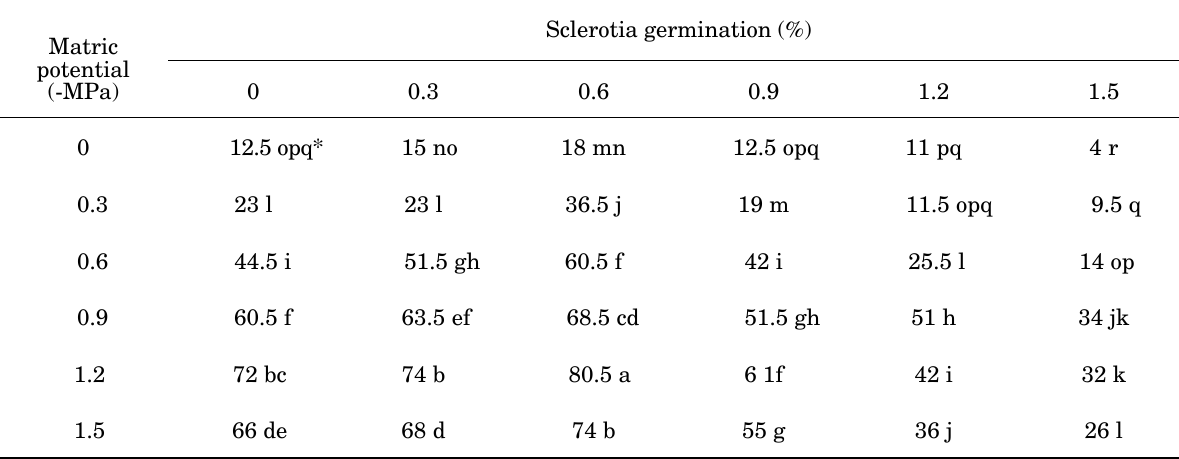
Fig. 1. Effect of matric and osmotic potential on sclerotial germination of Macrophomina phaseolina . In the matric and osmotic potential columns, values followed by the same letters are not signi fi cantly different at P ≤ 0.05 according to Duncan’s Multiple Range Test. Table 1. Effect of the matric and the osmotic potential (from 0 to 1,5 -MPa) and their interaction on sclerotia germi- nation of Macrophomina phaseolina .